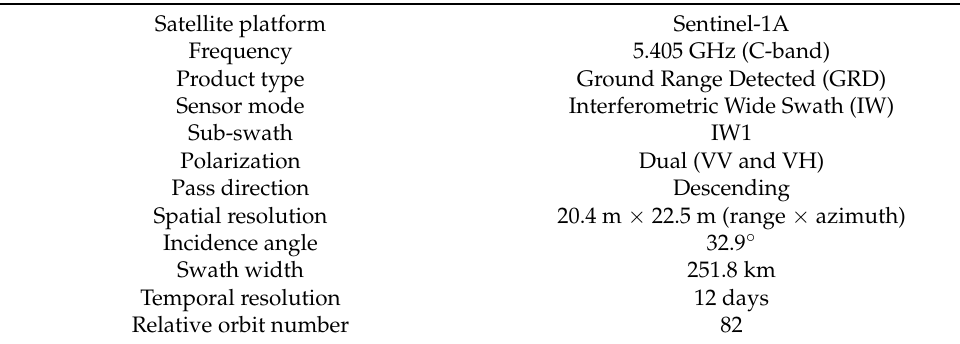
Table 1. Sentinel-1 data specifications.